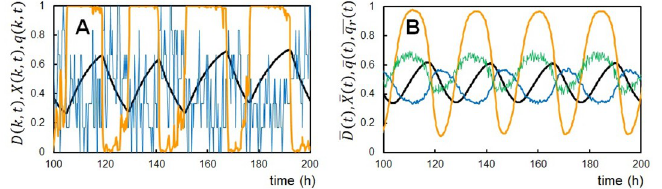
Fig 2. Example oscillations of the simulated KaiABC system. ( A ) The singlel-molecule oscillations of the phosphorylation level D ( k , t ) (black), the structural state X ( k , t ) (orange), and the ADP binding probability on the CI q ( k , t ) (blue) of an arbitrarily chosen k th KaiC hexamer. ( B ) The ensemble-averaged oscillations of the phosphorylation level � D ð t Þ (black), the structural state � X ð t Þ (orange), the binding probability of ADP on the CI � q ð t Þ (blue), and the ATPase activity measured by the amount of the released ADP � q ð t Þ (green). N = 1000 at temperature T 0 = r